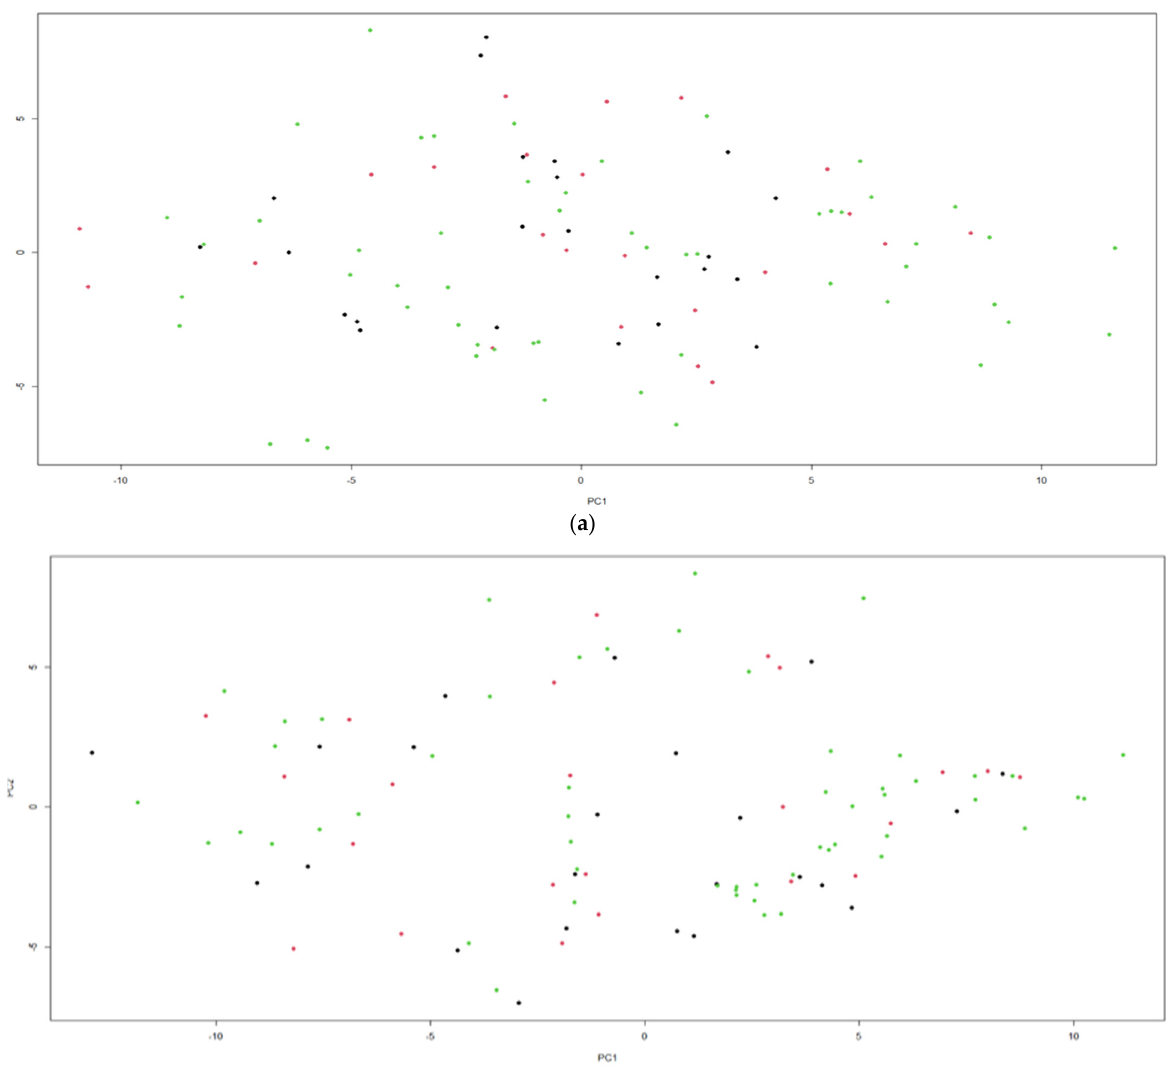
Figure 3. ( a ) K-means using 3 clusters for biological properties of Pleurotus ostreatus cultivated on two mixtures of agricultural wastes, ( b ) K-means using 3 clusters for biological properties of Pleurotus djamor cultivated on two mixtures of agricultural wastes.